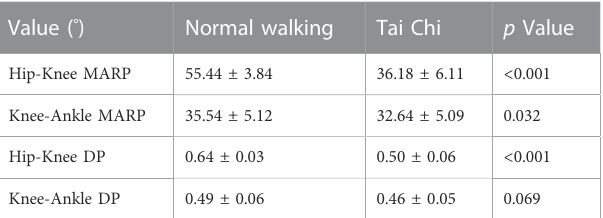
TABLE 1 Internal coupling relationship of the sagittal plane of the lower limb (Mean ± SD). Value ( ° ) Normal